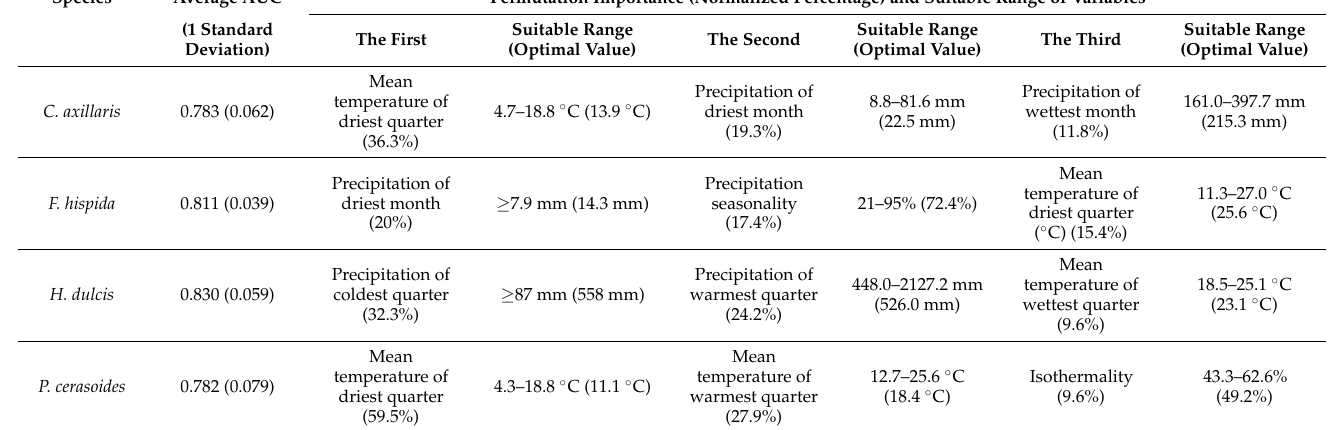
Table 4. Area under the receiver-operating characteristic curve (AUC), averaged over 10 models with one standard deviation and the importance of permutation of bioclimatic variables contributing to climatic niche models of each species. The first three most important variables and the average suitable range and optimum value of those variables are presented.